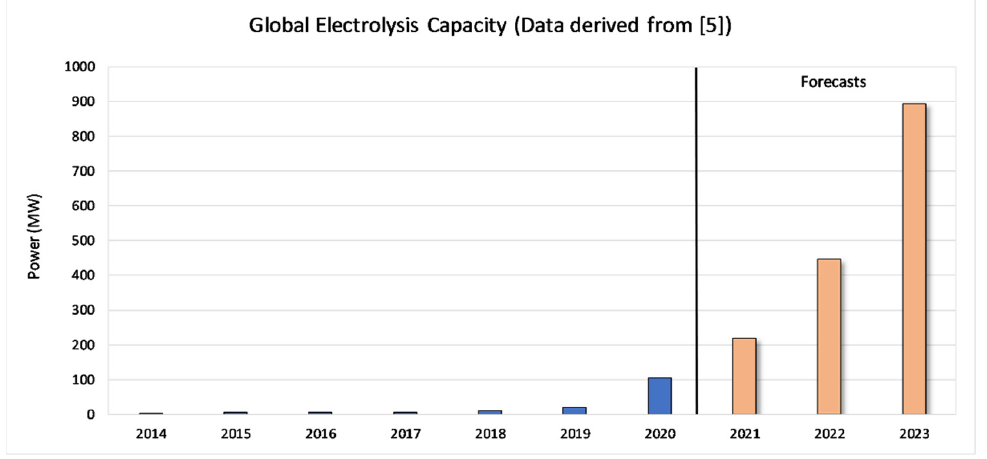
Figure 1. Constructed HRS and an estimation until 2023 [5].